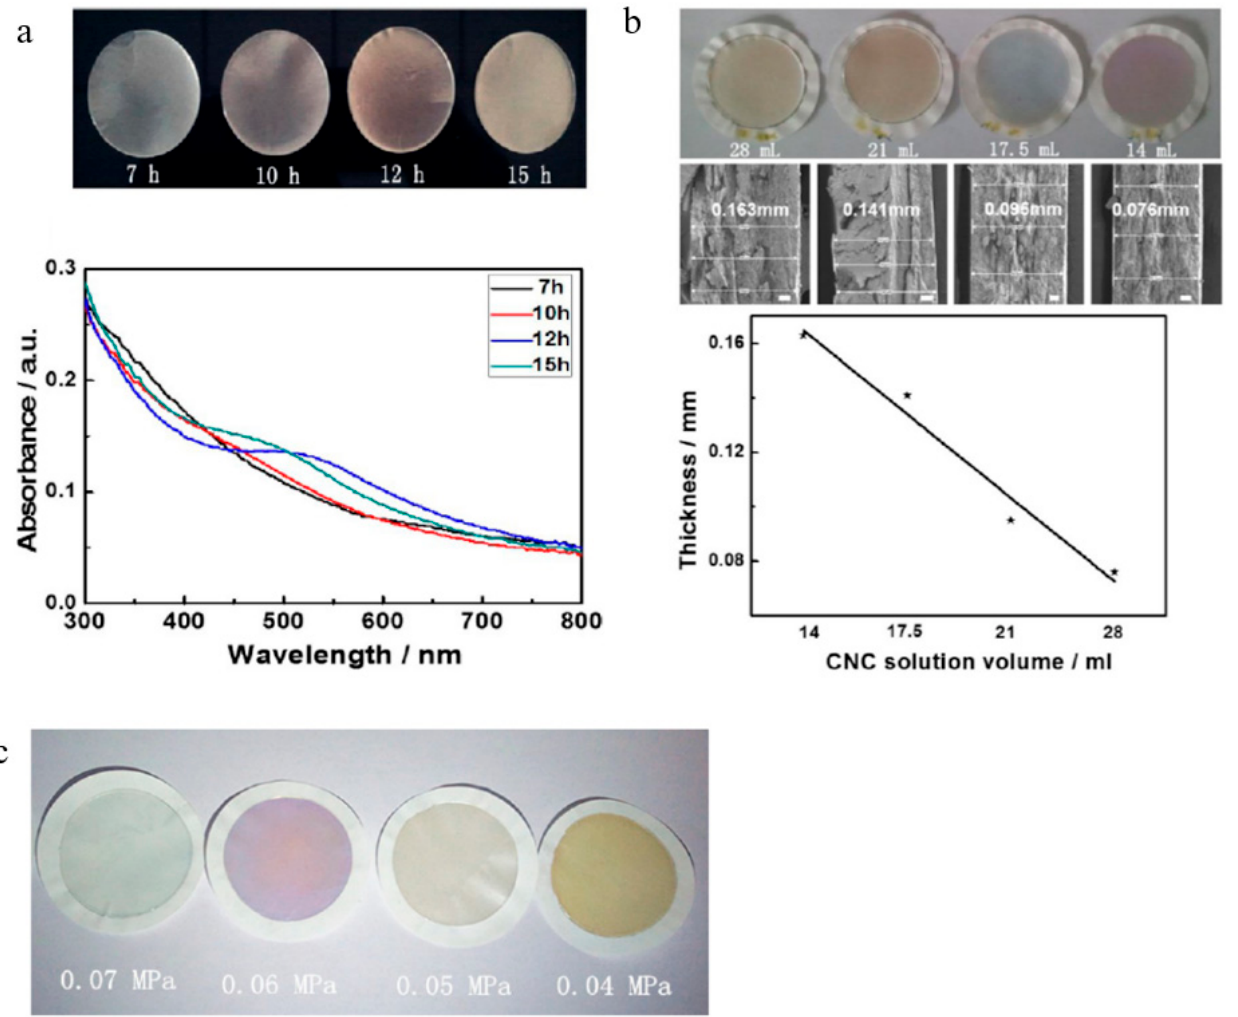
Figure 15. ( a ) Photographs of CNC iridescent solid films prepared with varying sonication times and their UV-Vis spectra; ( b ) optical photographs of CNC iridescent solid films prepared with varying CNC suspension volumes and their SEM images of the cross-sections, and a plot of film thickness as a function of CNC suspension volume; ( c ) photographs of CNC iridescent films prepared with various degrees of vacuum. Reproduced from [109].